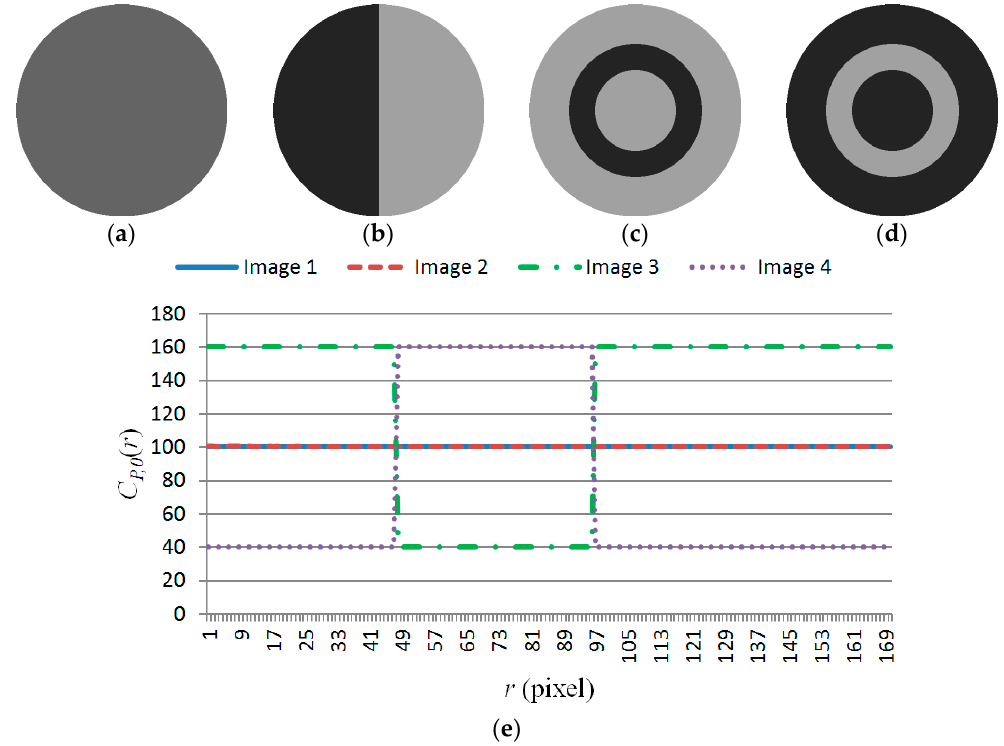
Figure 7. ( a – d ) Textures ‐ less searching images 1–4; ( e ) Corresponding ring projection features.